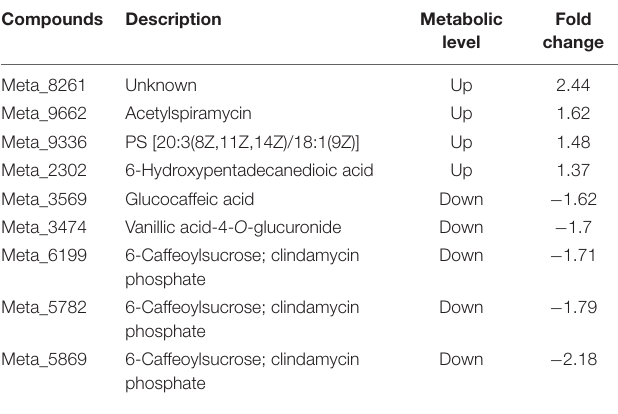
TABLE 6 | Nine differential metabolites detected in the Ri + Pf + Th treatment compared with Fo treatment from tomato shoots. Compounds Description